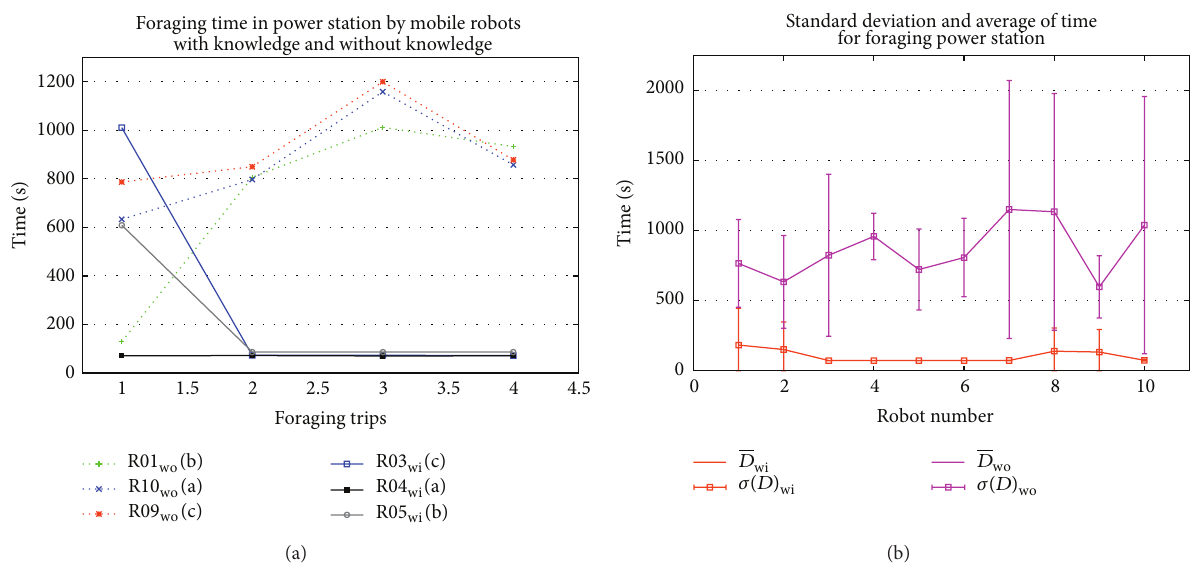
Figure 10: Analysis of foraging time consumption in environment with knowledge sharing and without knowledge sharing based on (a) 3 mobile robots in each environment and (b) average and standard deviation of times consumption for 10 mobile robots.